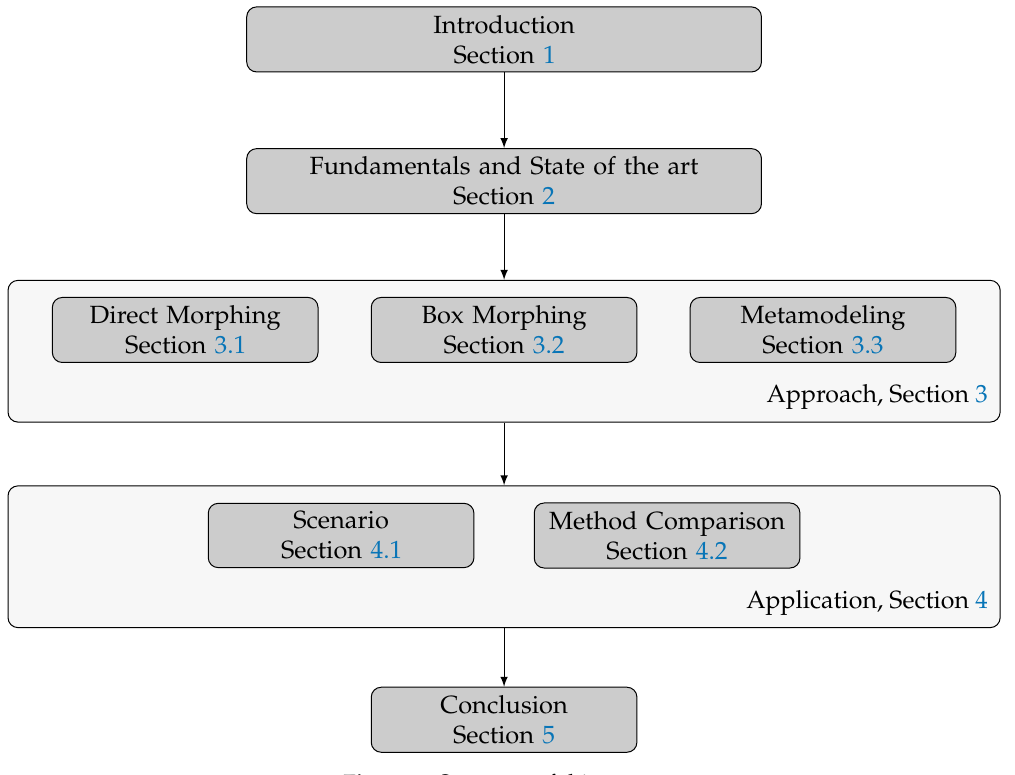
Figure 1. Structure of this